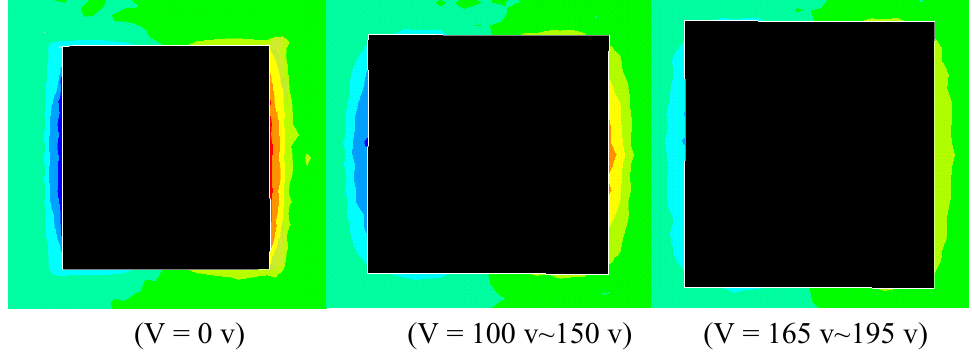
Figure 15. FEM simulation of shear stress distributions along delamination edges with different voltages (adopted from Figure 4 in